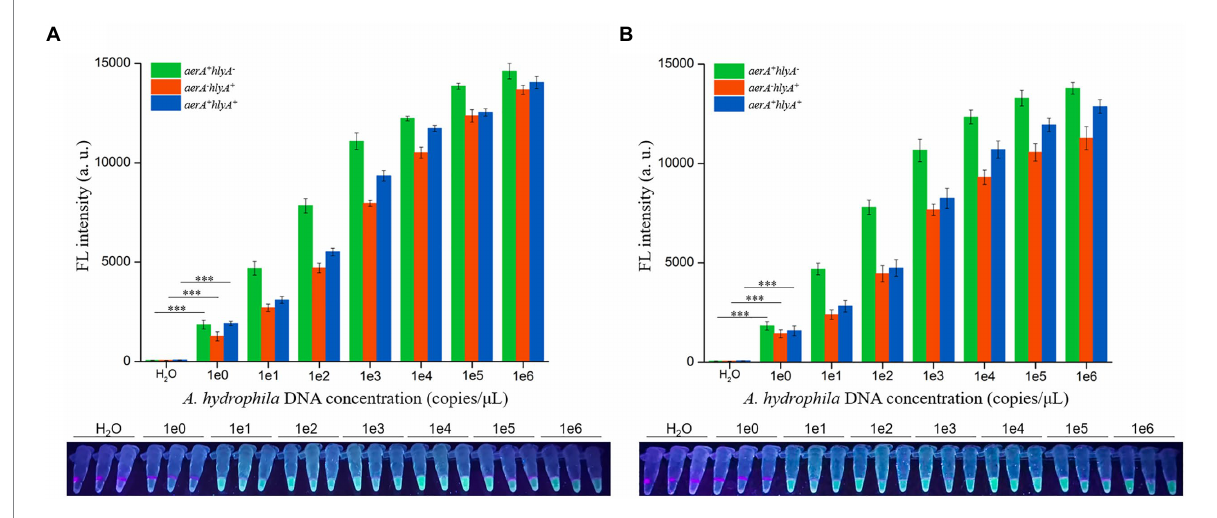
FIGURE 4 Sensitivity evaluation. Sensitivity of dRAA-CRISPR/Cas12a (A) and dPCR-CRISPR/Cas12a (B) assays were evaluated in the detection of pathogenic Aeromonas hydrophila . The different concentrations (1 × 10 0 –1 × 10 6 copies/ μ l) of A. hydrophila genomic DNA were used as the detection template, and H 2 O was used as a negative control. The results were read using an UV flashlight (below) or a multifunctional microplate reader (upper). n = 3 technical replicates; two-tailed Student’s t test; *** p < 0.001, experimental group versus corresponding negative control group (only shown the 1e0 vs. H 2 O); bars represent mean ± SEM.